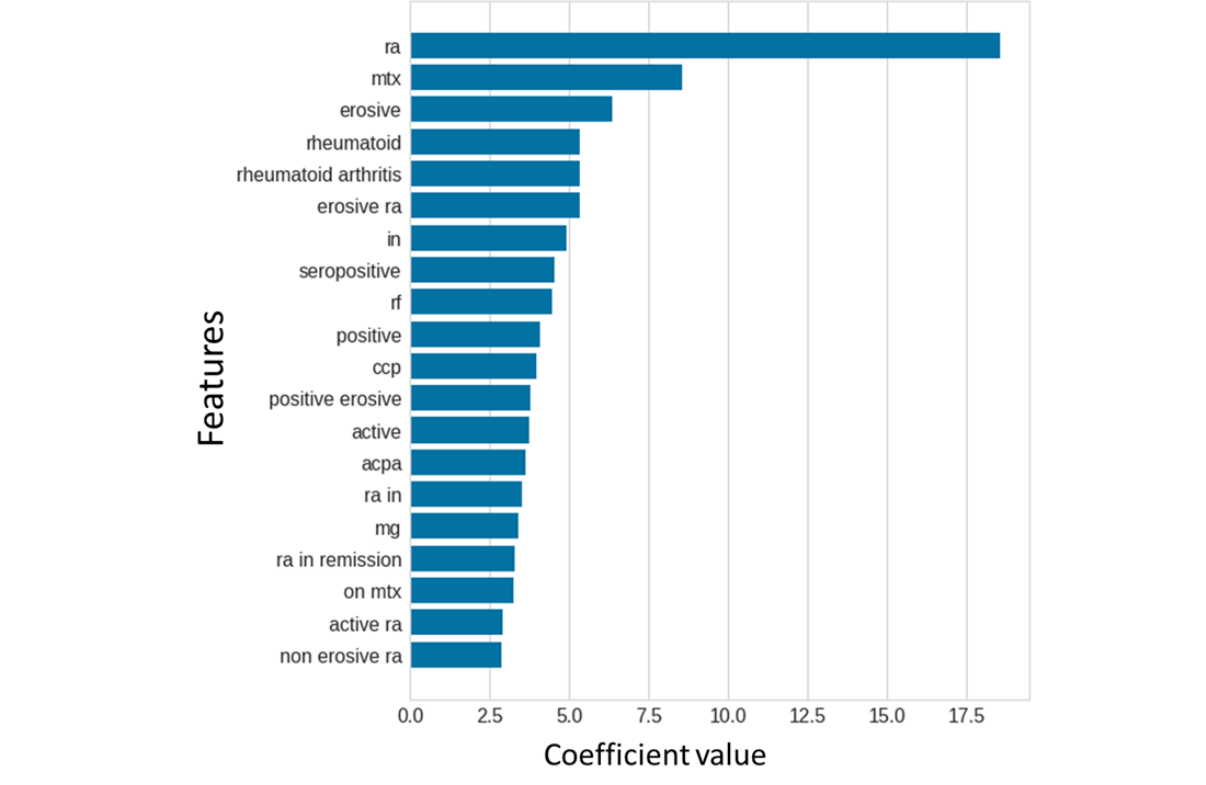
Figure 3. The relative importance (coefficients) of the top 20 features in the Leiden-A data set according to the final support vector machine model. The initial data was in Dutch, we translated the words to English in this figure to improve